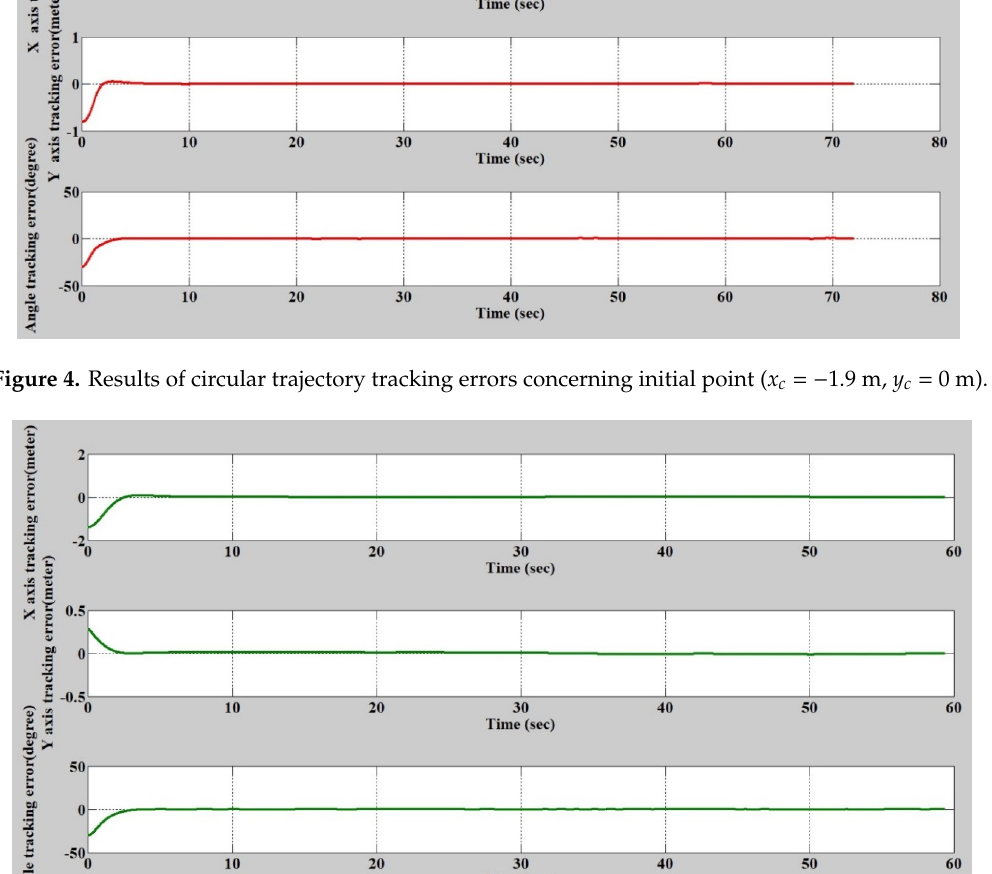
Figure 5. Results of circular trajectory tracking errors concerning initial point ( x c = 0 m, y c = 1.9 m).